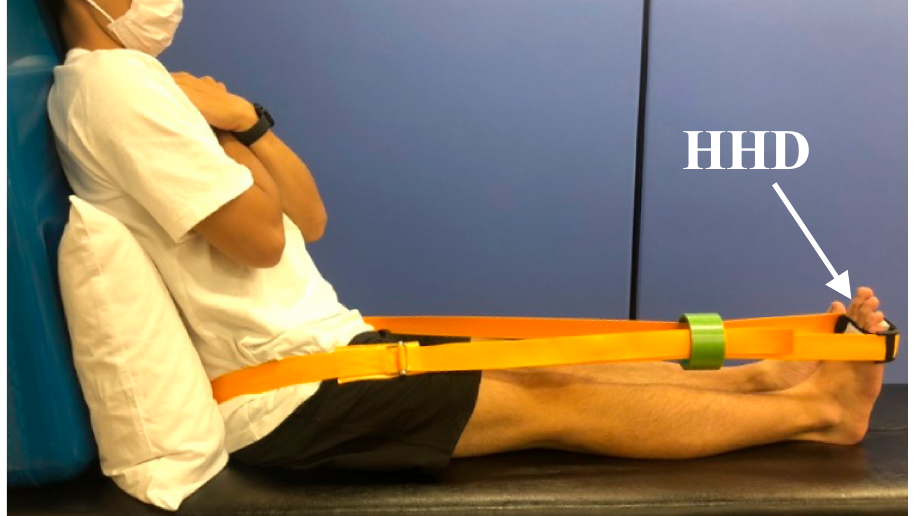
Figure 1. Measurement of ankle plantarflexion muscle strength. Participants sat on a bed with their backs against the backrest. The backrest was set to tilt backward by 30 ◦ . The hand-held dynamometer (HHD) was attached to the sole and the ankle joint was fixed to the neutral position. The ankle plantarflexion angular velocity was measured using a gyroscope (45 × 45 × 18 mm; MicroStone Corporation, Nagano, Japan) (Figure 2). The gyroscope was fixed onto the distal end of the second metatarsal bone at the dorsum of the foot so that the axis of the sensor was aligned with the sagittal plane [18]. The data from the gyroscope were captured